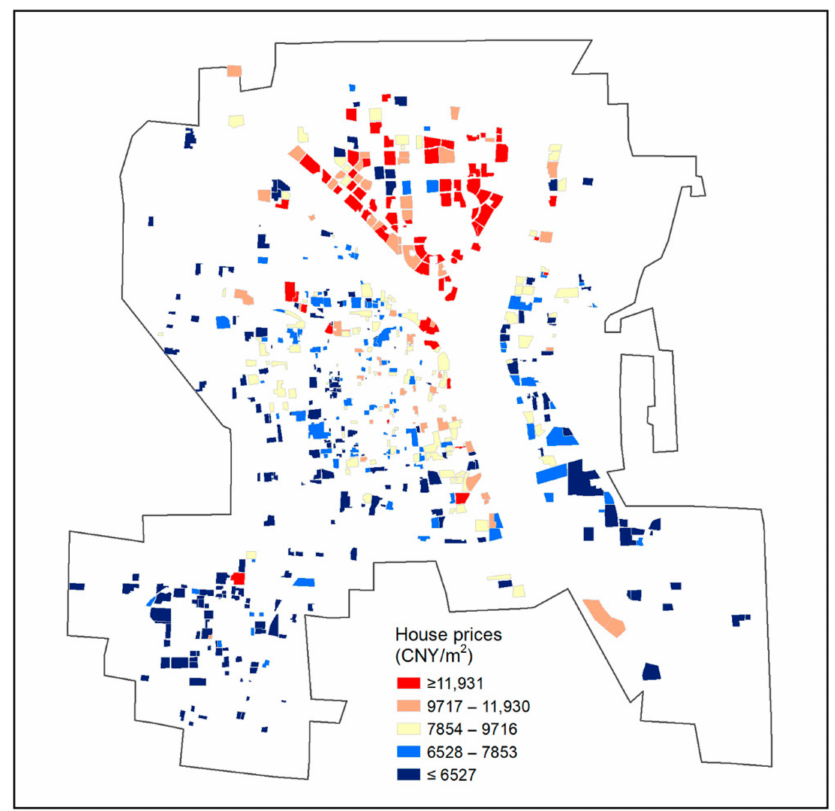
Figure 11. Spatial pattern of average real-estate transaction prices of communities in 2019.